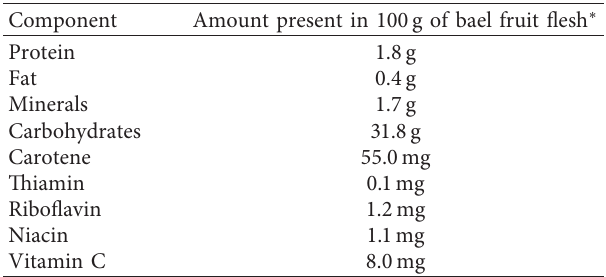
Table 1: Nutrient profile of the bael